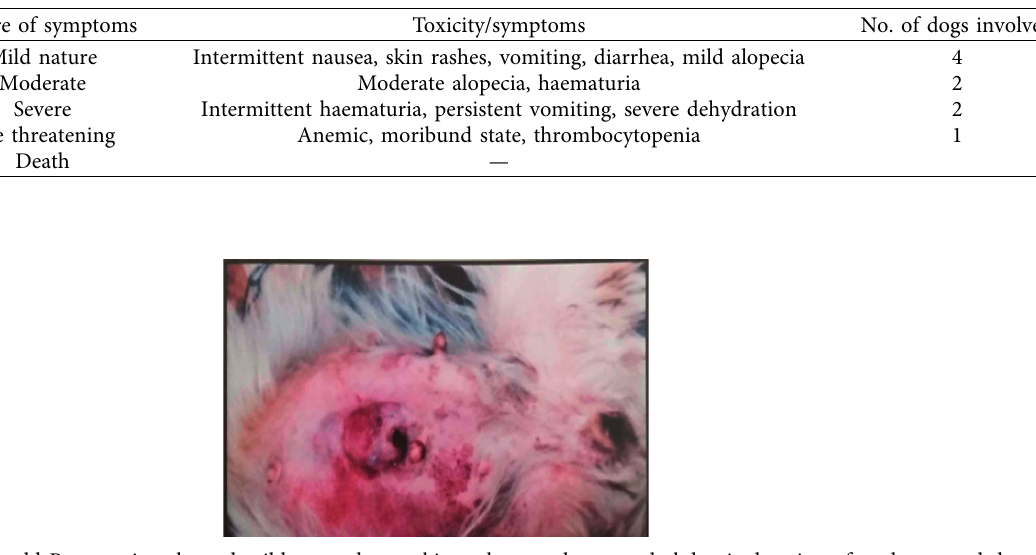
Figure 6: An 8-year-old Pomeranian showed mild-to-moderate skin rashes on the ventral abdominal region after the second dose of cyclophosphamide with recurrence of